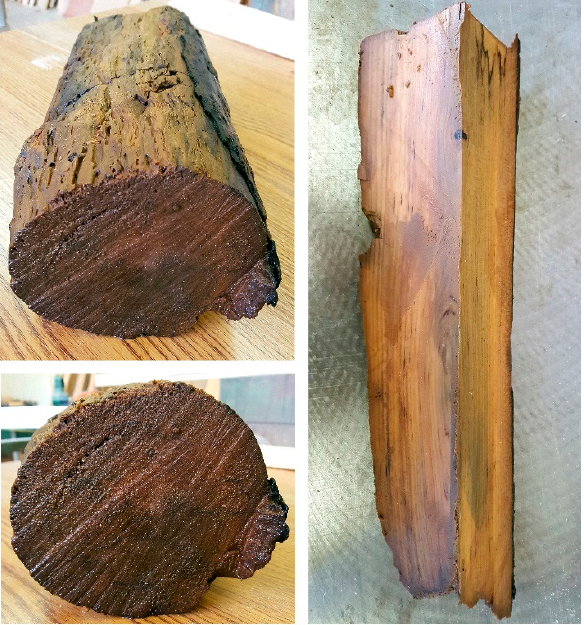
Figure 1. Waterlogged elm ( Ulmus spp.) wood excavated from the Lednica Lake (dated back to the 10–11th centuries).